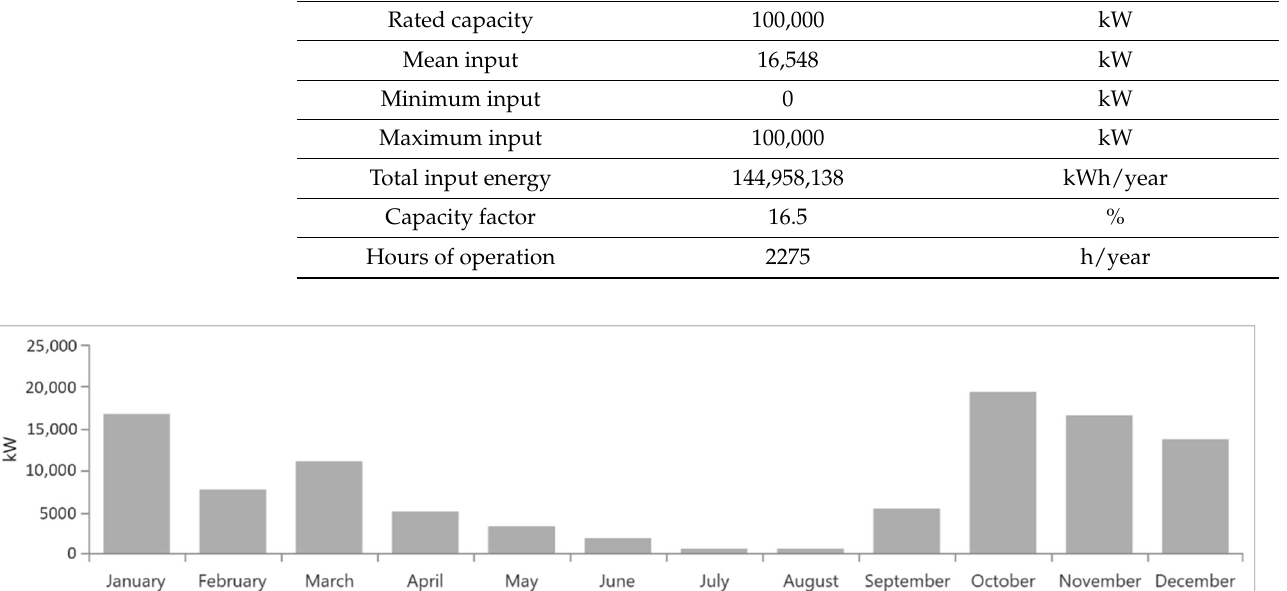
Table 5. Electrolyzer operation.